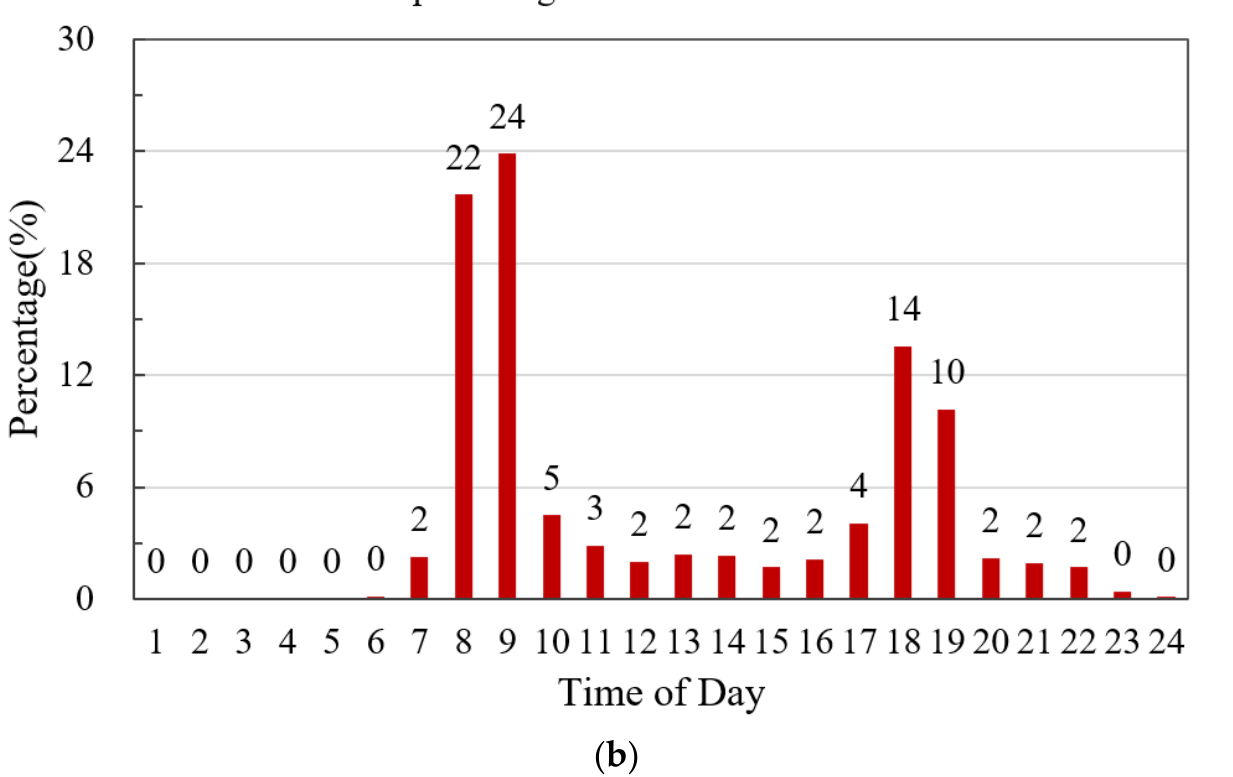
Figure 7. Temporal distribution of the bikeshare usage. ( a ) Transfer trips extracted from seamless bikeshare smartcard data and metro smartcard data, ( b ) Transfer trips extracted from dedicated bikeshare card data and metro smartcard data.